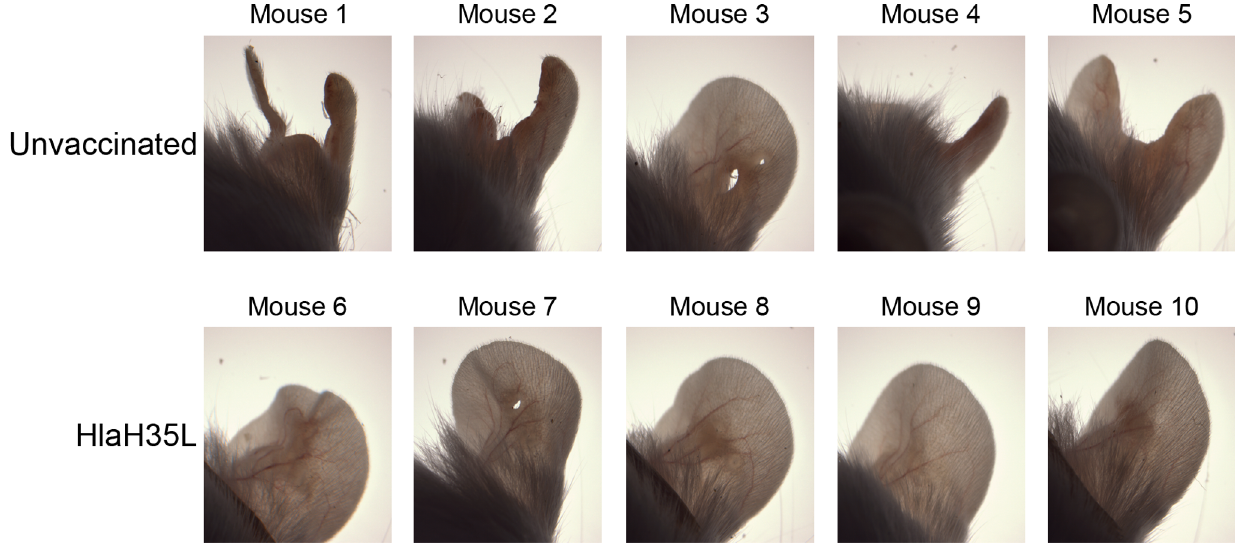
Figure 1. Assessment of tissue damage from SSTI in control vs HlaH35L-immunized mice. Photographs were taken on day 14 post- challenge.